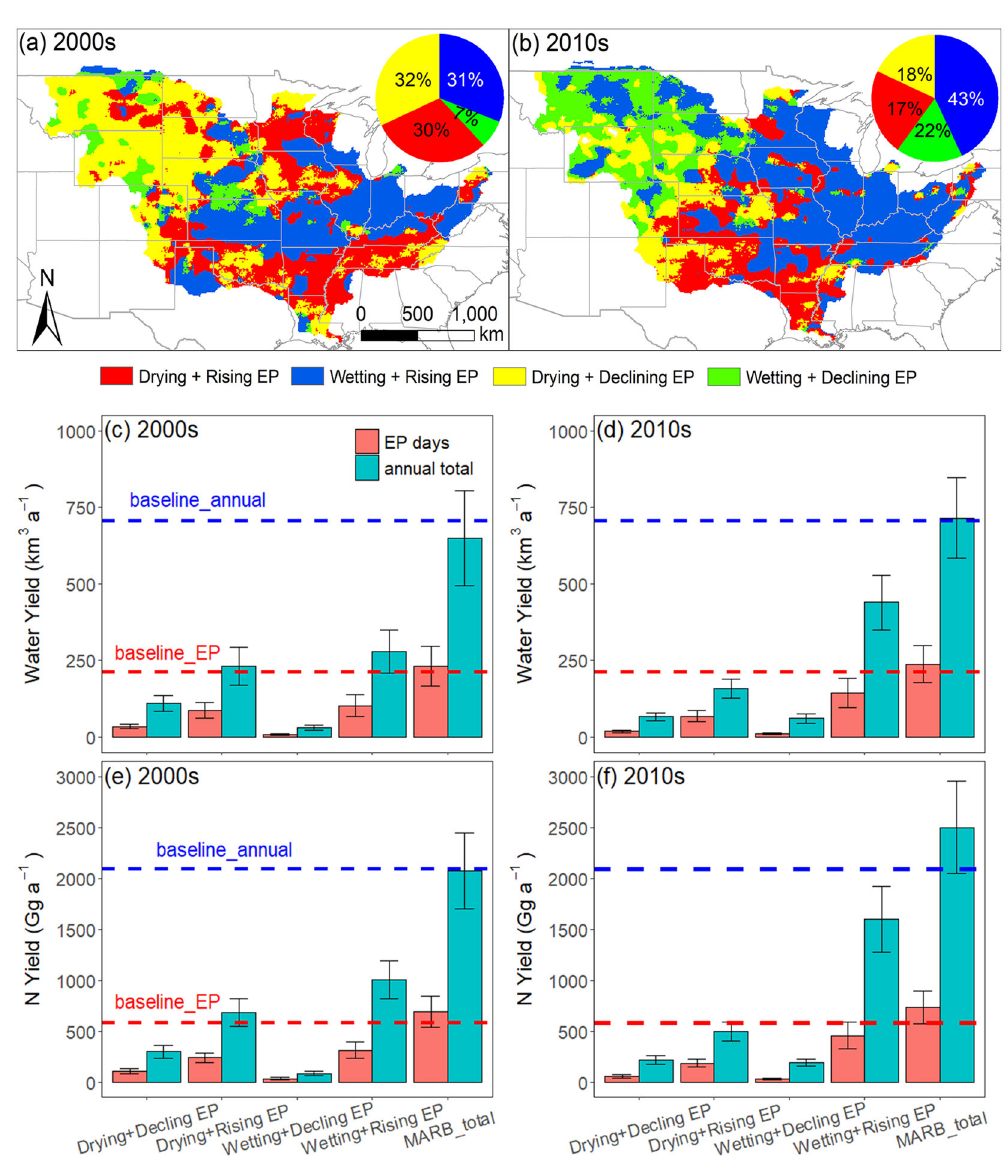
Fig. 6 Water yield and N yield in different precipitation categories across the Basin. Superimposition of trends in extreme precipitation (EP) and annual precipitation is used to spatially classify the grid cells of the Basin into four categories in the 2000s ( a ) and 2010s ( b ). The 24-month SPI was calculated for the 1980s to the 2010s. The average SPI of the period 1980 – 1999 was calculated as the baseline SPI. Drying and wetting trends were de fi ned as negative and positive anomalies, respectively, of the SPI in the past two decades relative to the baseline SPI. The pie charts in a , b represent the area percentage of each category in the entire Basin. The modeled water yield (i.e., the sum of surface and sub-surface runoff, c , d ) and N yield (i.e., N leaching from soils, e , f ) in extreme precipitation days and the whole year averaged in the 2000s and the 2010s were summed for the four moisture groups in the Basin. The red and blue dashed lines in c – f represent the baseline average water and N yield in extreme precipitation days and the annual total during 1980 – 1999, respectively. The error bars (standard deviations) in c , d and e , f , respectively, indicate the inter-annual variabilities of water yield and N yield over each decade under each